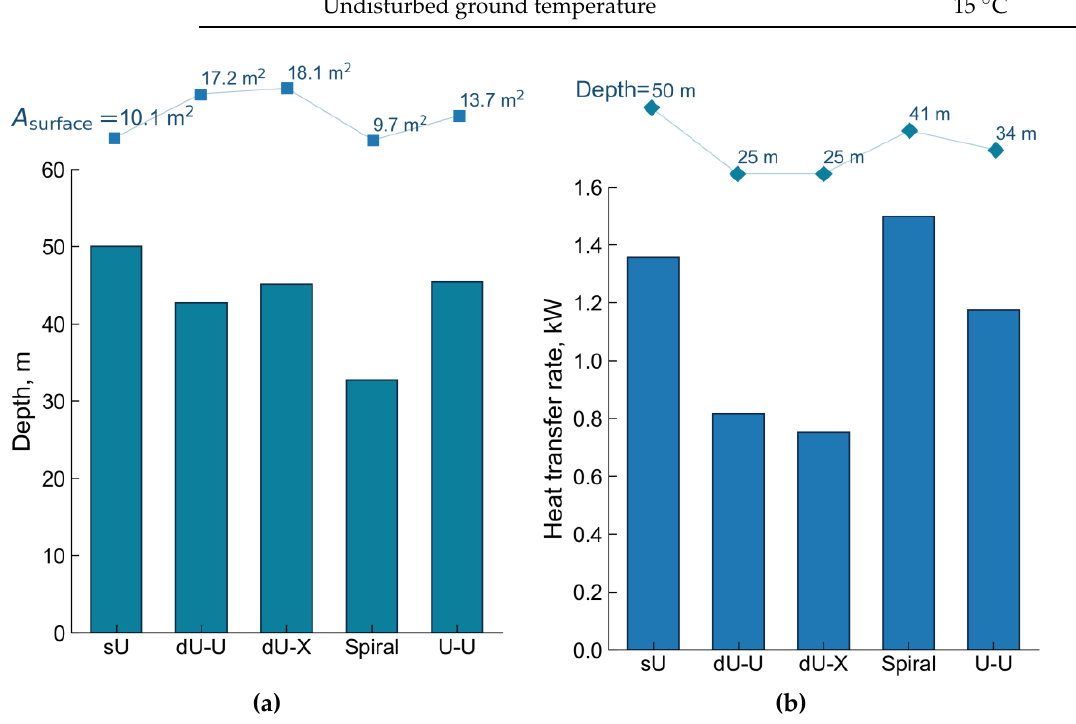
Figure 14. Geometric parameter effects: ( a ) well depths for various pipe configurations at a constant heat flow 𝑄 = 1350 W; ( b ) heat transfer rates for various pipe configurations with a constant heat exchange surface area 𝐴 𝑠𝑢𝑟𝑓𝑎𝑐𝑒 = 10.05 m 2 .